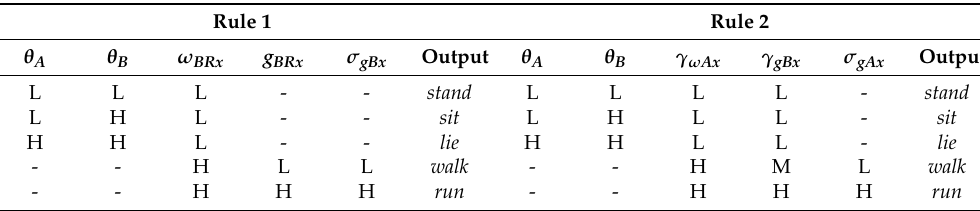
Table 2. Fuzzy logic rules with respect to both feature sets for